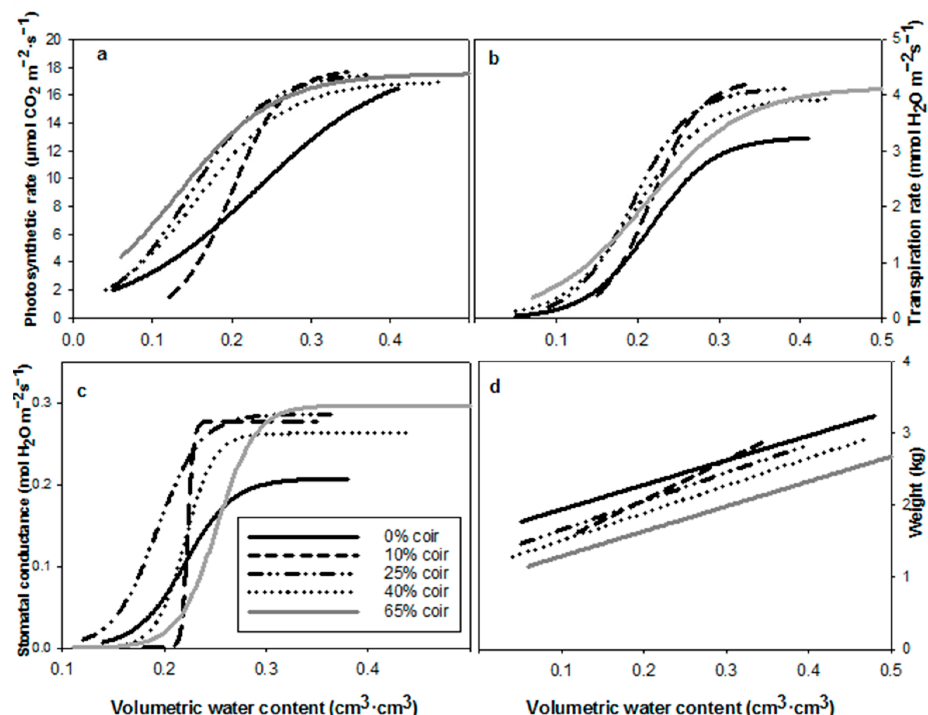
Figure 2. The relationship between plant photosynthetic rate ( a ), transpiration rate ( b ), stomatal conductance ( c ) and container weight ( d ) with substrate volumetric water content (VWC) of Hydrangea paniculata ‘Jane’ (Little Lime ® hardy hydrangea) plants grown in a pine bark substrate amended with 0%, 10%, 25%, 40% or 65% of coir by volume in August 2018. Data for photosynthetic rate, transpiration rate, stomatal conductance were characterized by a 3 parameter sigmoidal curve while container weight was characterized by a simple linear relationship. Each line represents one treatment from eight replications (n = 8). a = photosynthetic rate and VWC, b = transpiration rate and VWC, c = stomatal conductance and VWC, d = weight and VWC.